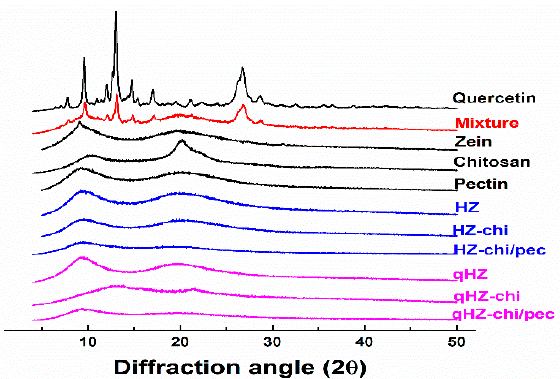
Figure 3. XRD diffraction patterns of quercetin, mixture (quercetin, zein, chitosan and pectin), zein, chitosan, pectin, HZ, HZ-chi, HZ-chi/pec, qHZ, qHZ-chi, qHZ-chi/pec.